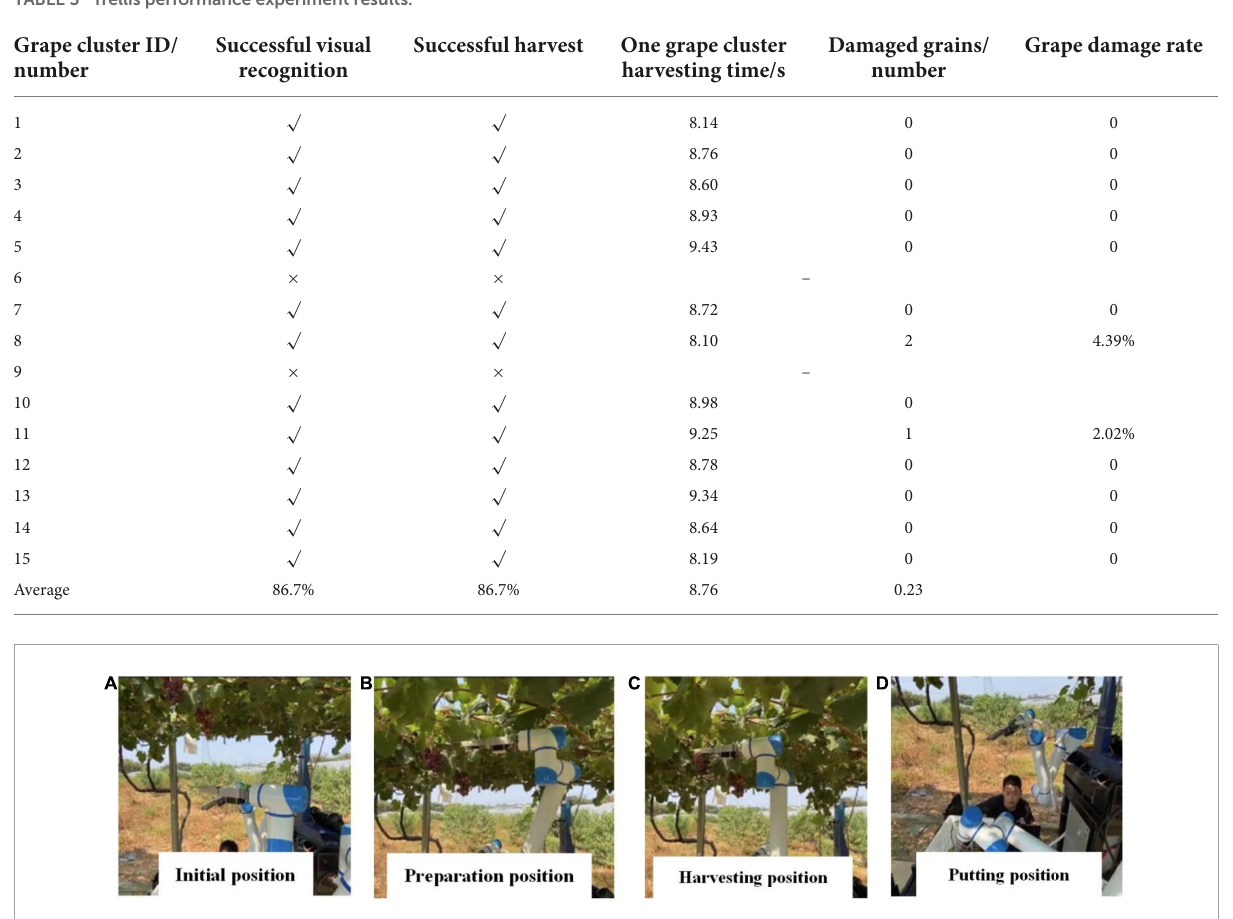
FIGURE17 Robotic arm harvesting postures: (A) initial position; (B) harvesting preparation; position (C) harvesting position; and (D) putting position.